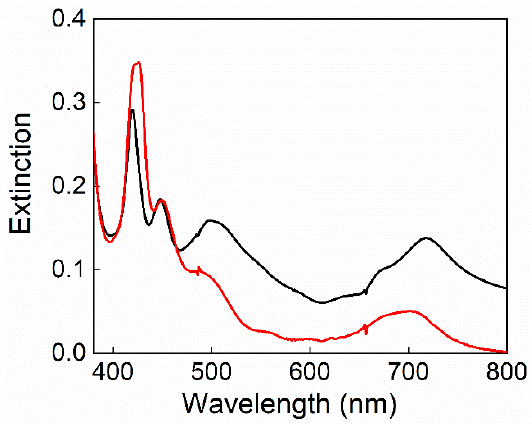
Figure 1. Extinction spectra of 0.77 wt % TPPS / sulfonated poly(etheretherketone) (s-PEEK) dispersion in dimethyl acetamide (DMAc). Instantaneously after filler addition (black line) and in sol phase after 90 min at 80 °C (red line).